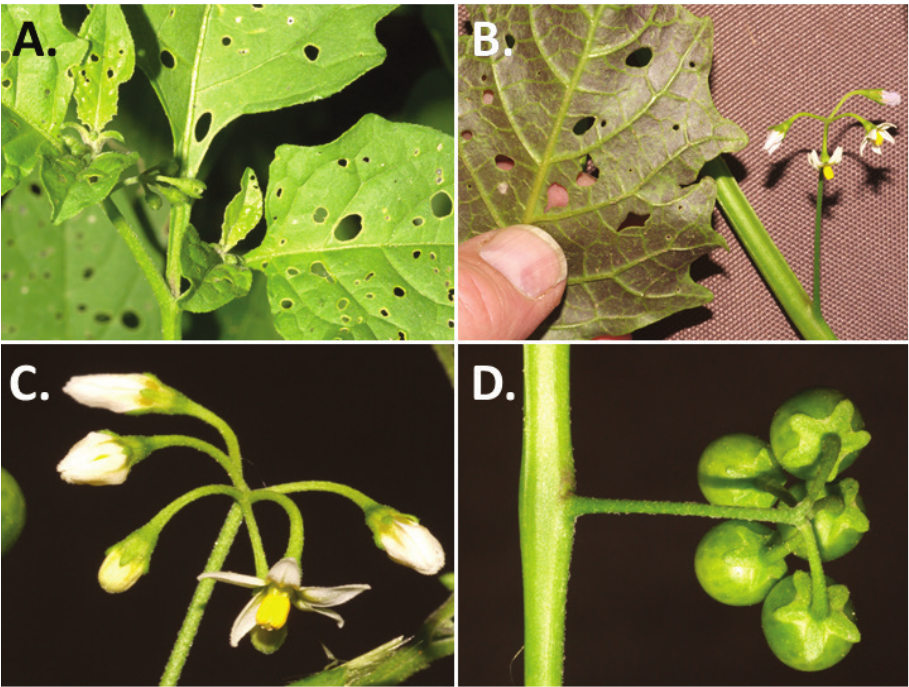
Figure 16. Solanum emulans Raf. A Leaves and buds B leaf abaxial surface and inflorescence C buds and flower at full anthesis D developing fruits with appressed calyx lobes ( A, C, D Nee 61357 ; B Nee 61306 ). Photos by M.